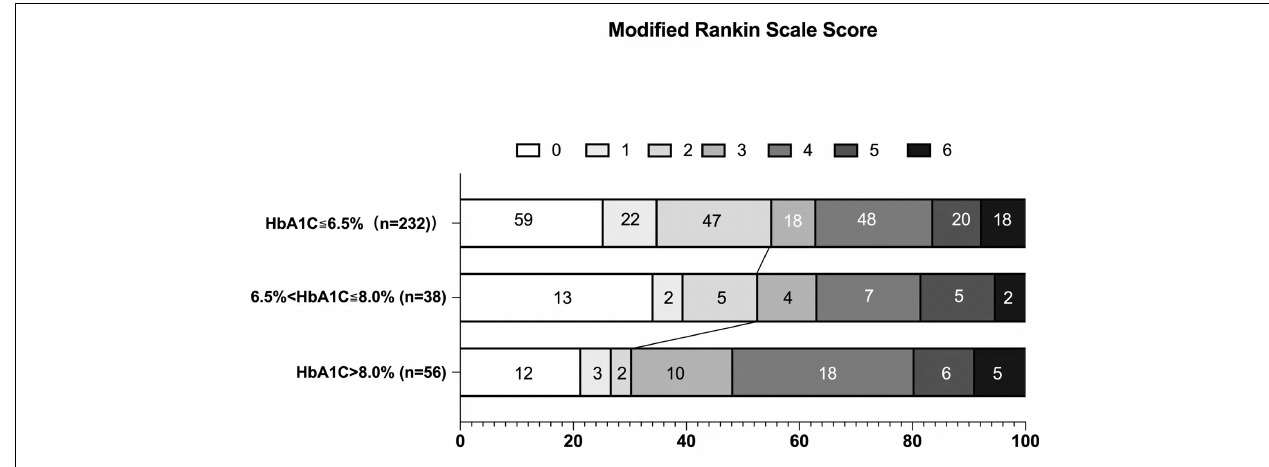
FIGURE 1 | Distribution of scores on the modified Rankin Scale at 90 days.